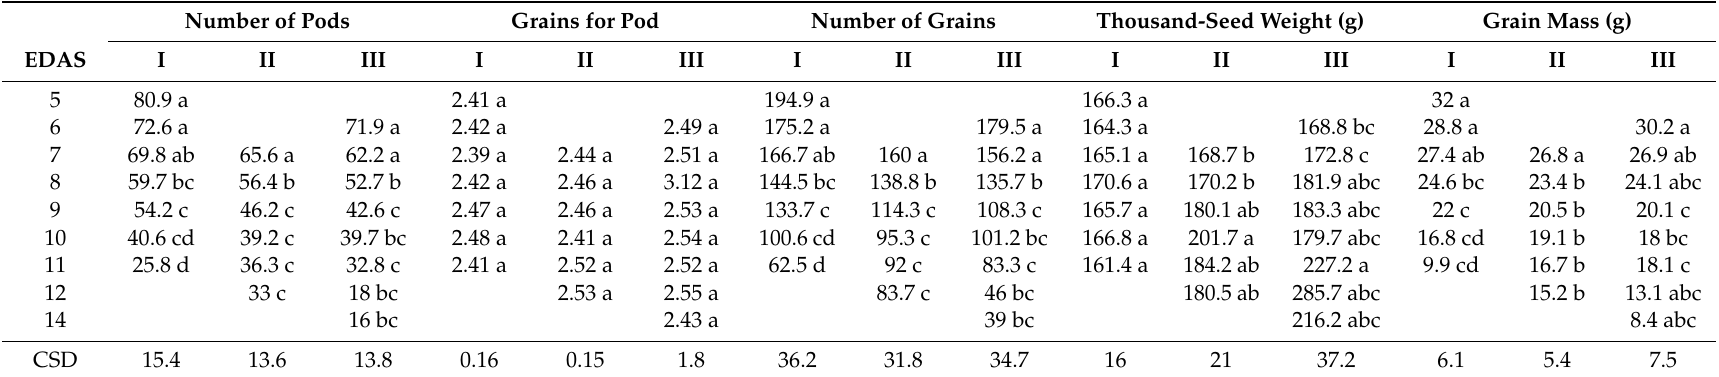
Table 5. Number of pods, grains for pod, number of grains for plant, thousand-seed weight, and grain mass in stage R 8 in soybean plants from distinct emergence days after sowing (EDAS)* at the three sites (I, II, and III). Number of Pods Grains for Pod Number of